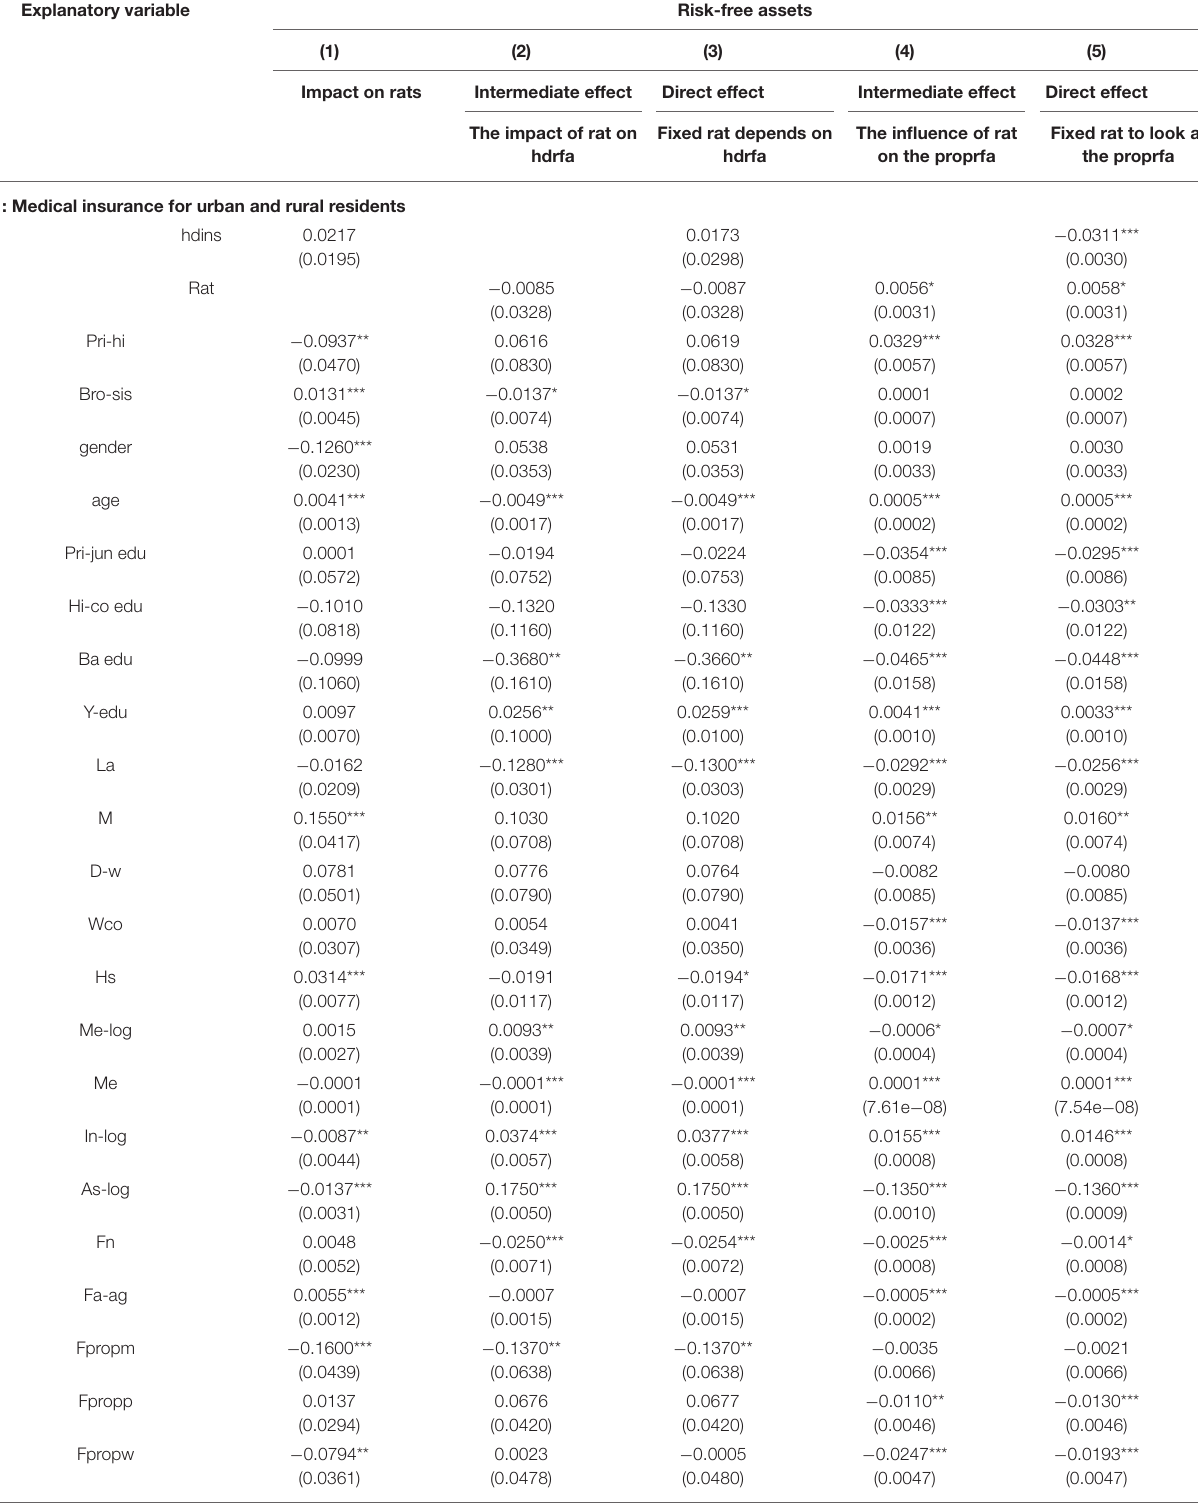
TABLE 7 | Intermediary effect regression (replacing definitions of financial assets, risk-free